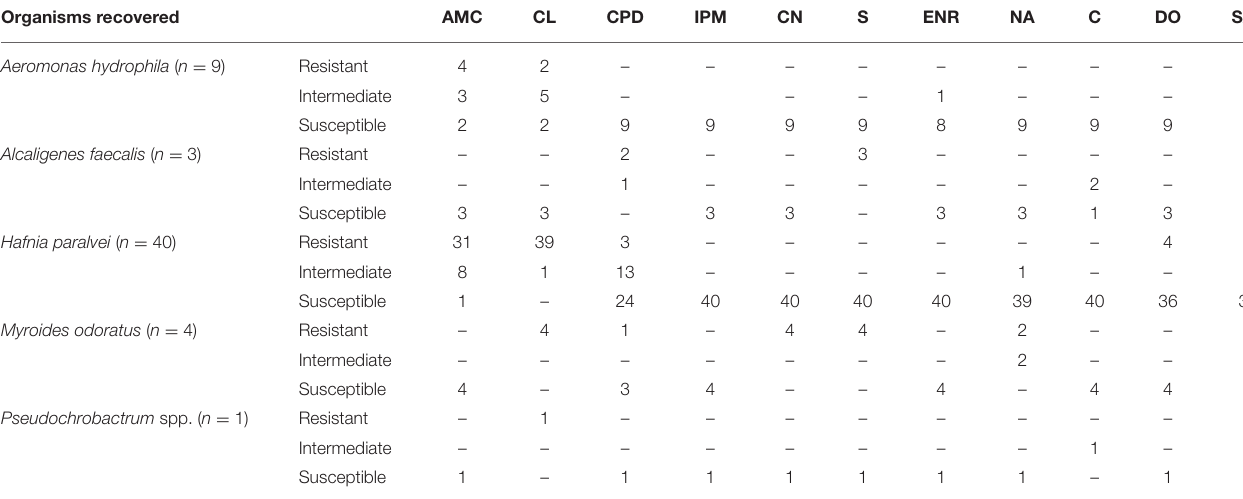
TABLE 3 | Susceptibility to non-polymyxin antibiotics among polymyxin-resistant organisms recovered from Victorian poultry farms. Organisms recovered